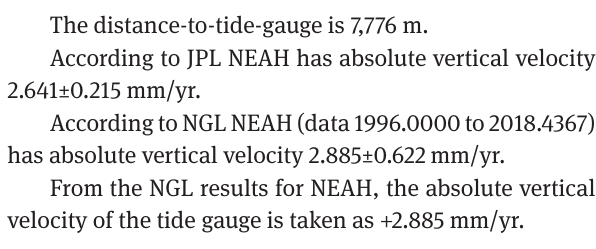
±0.30 mm/yr., based on MSL data from 1934/8 to 2017/12. The acceleration is -0.01619±0.02760 mm/yr 2 .